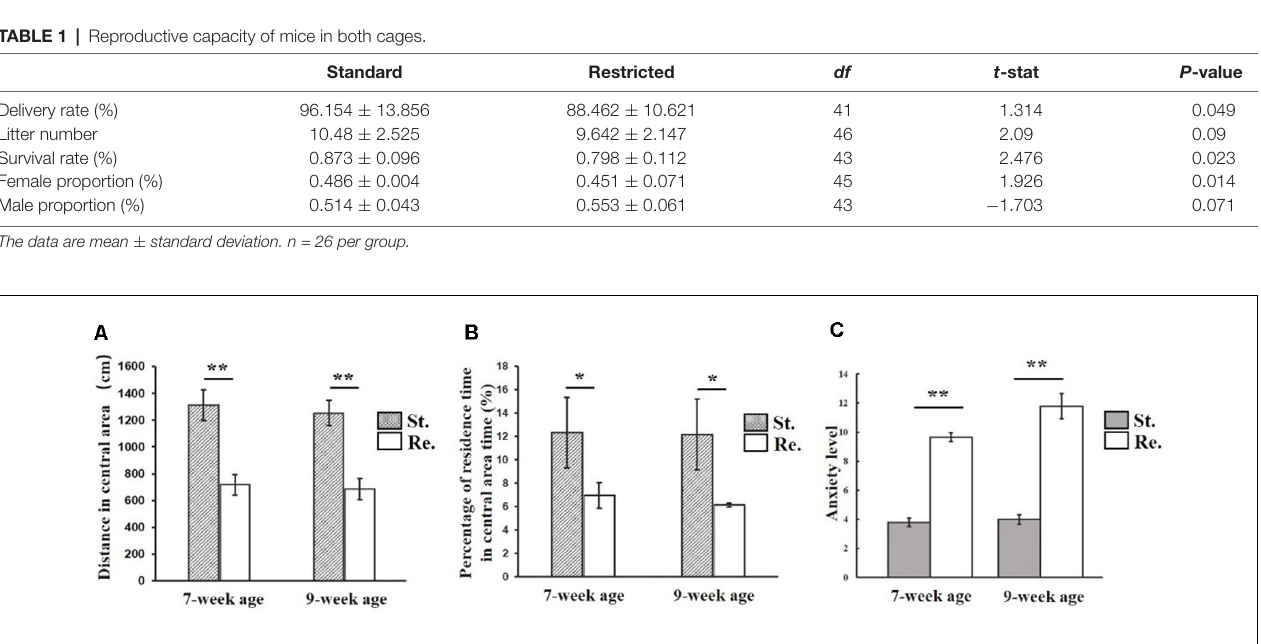
( t ( 70 ) = − 2.341, P = 0.021) and at the 4th test day for the 9-week groups ( t ( 72 ) = − 2.759, P = 0.03) that the cage